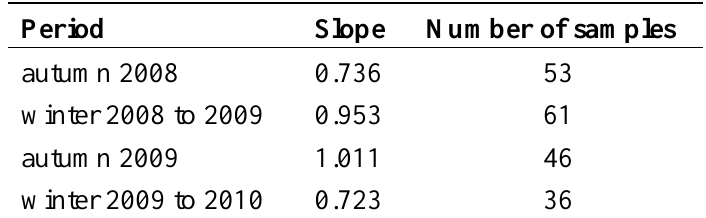
Table 1. Summary of the slope of the best-fit straight line between LIDAR-derived AOD and sunphotometer-measured AOD in different seasons. Only those periods with more than 30 samples are considered. The value of k = 1.4 is